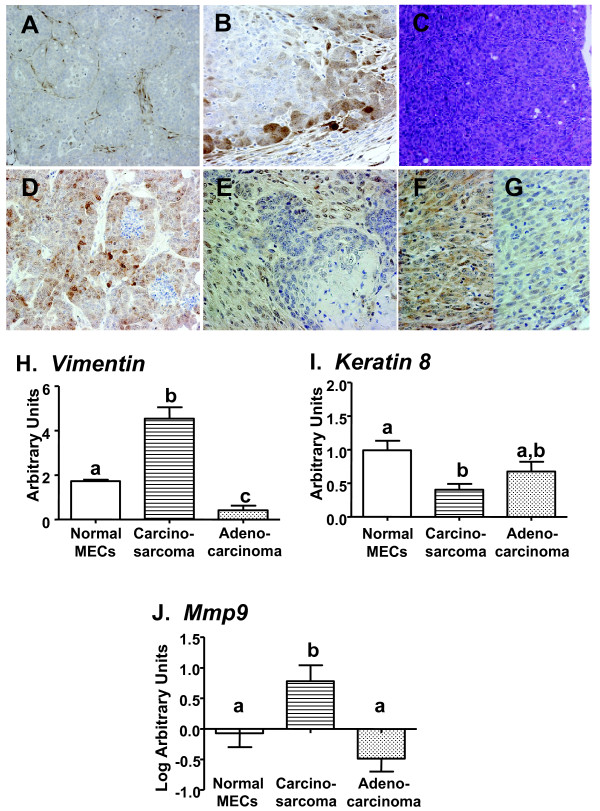
Adenocarcinomas exhibit activated ERK1/2 in stroma and AKT in epithelia; carcinosarcomas display strong epithelial pERK1/2. (a) pERK1/2 localized in stromal cells of differentiated glandular adenocarcinomas. (b) Mammary carcinosarcomas demonstrated nuclear and cytoplasmic staining for pERK1/2. (c) Carcinosarcoma from gland of NRL-PRL female (hematoxylin and eosin stain). (d) Glandular adenocarcinoma from NRL-PRL female demonstrating nuclear and cytoplasmic staining for pAKT. (e) pAKT localized primarily in the stroma of a squamous adenocarcinoma. (f, g) Carcinosarcomas demonstrated variable levels of pAKT expression. (h) Carcinosarcomas demonstrated significantly higher levels of vimentin mRNA compared to either morphologically normal MECs or more differentiated adenocarcinomas from NRL-PRL females. (i) Carcinosarcomas had similar levels of keratin 8 transcripts compared to adenocarcinomas. (j)Mmp9 mRNA was significantly increased in carcinosarcomas. Transcript levels were measured using qRT-PCR as described in Materials and Methods and represented as mean ± s.e.m. (MECs, N = 3 samples, each containing RNA pooled from 5 mice; carcinosarcomas, N = 4; adenocarcinomas with high pStat5, N = 5). Letters denote significant differences using ANOVA, followed by Newman-Keuls post test (P < 0.05). Original magnification: a, c, 200x; b, d, e, f, g, 400x.